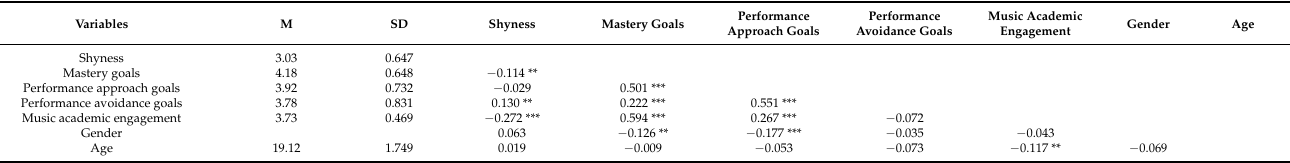
Table 1. Means, standard deviations, and correlations